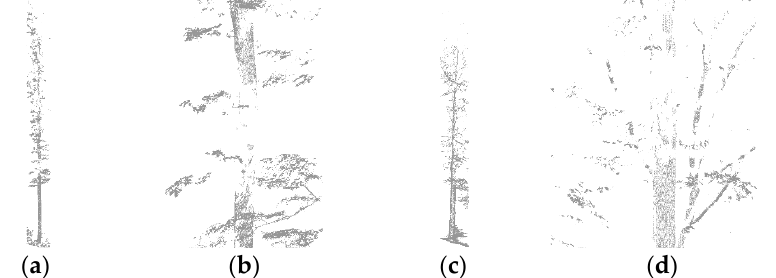
Figure 2. Examples of point clouds acquired at one of the Phalsbourg test sites. The point clouds exhibit large occluded areas on the stem. ( a ) Isolated tree; ( b ) Close-up view of branches; ( c ) Isolated tree; ( d ) Close-up view of branches.